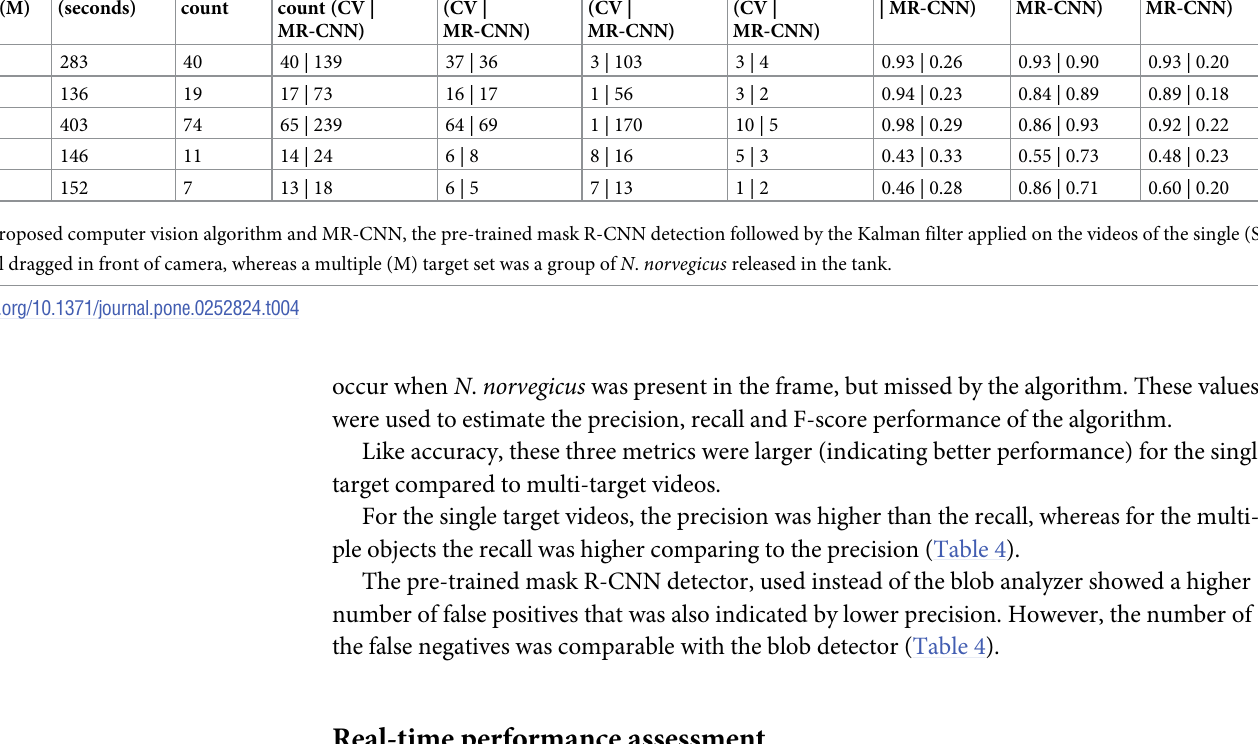
the false negatives was comparable with the blob detector (Table 4).